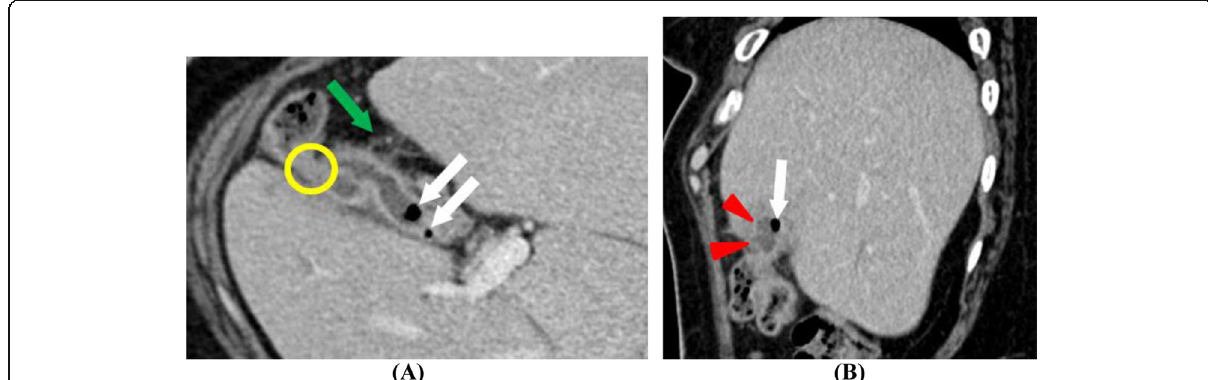
Fig. 17 Colo-cholecystic fistula with subsequent cholecystitis in a 65-year-old female patient presented with right hypochondrial pain and fever with history of gall bladder biopsy. Post contrast axial CT reformatted image ( a ) and sagittal reformatted image ( b ) showing irregular outline of gall bladder (red arrowheads) with multiple intra-luminal air foci (white arrows), its fundus tethered to hepatic flexure (yellow circle) with related mild fat stranding (green